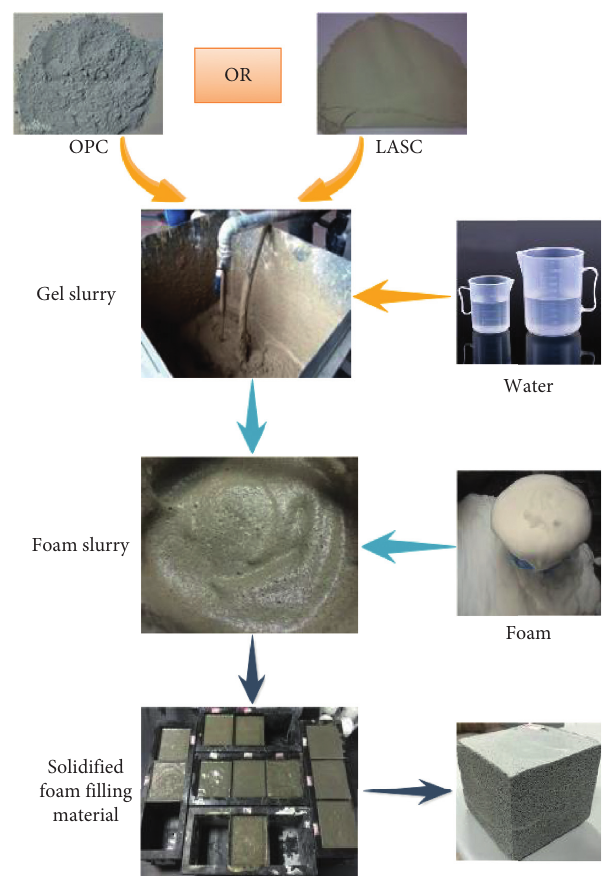
Figure 3: Schematic diagram of the preparation of the filling material. Table 5: Mixing ratio of foam and gel slurry.